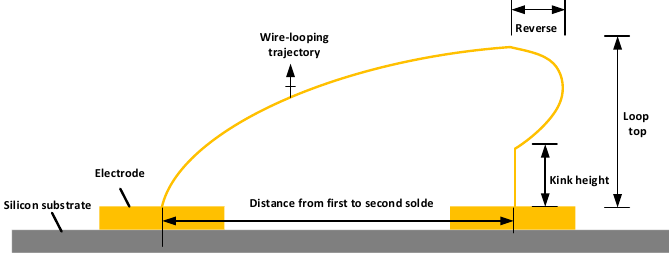
Figure 2. 3D schematic diagram of key parameters of gold wire ball welding bonding.